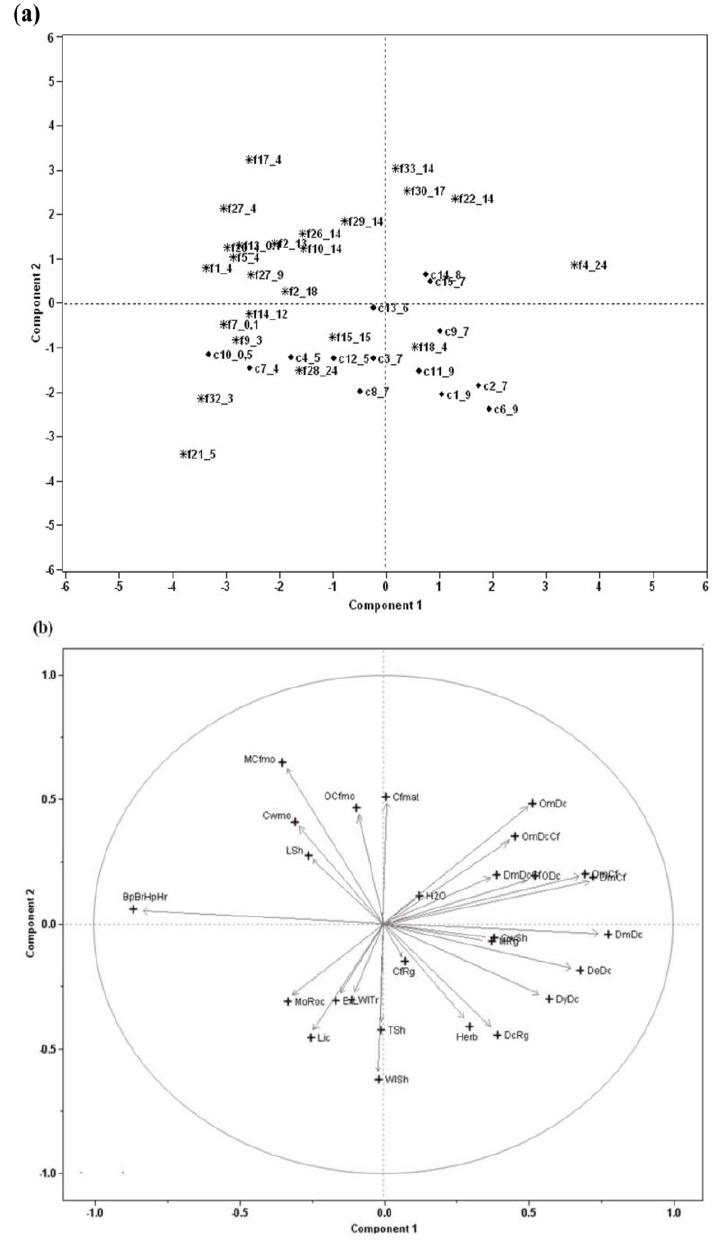
Figure A1. PCA showing the post-disturbance of the land cover types from images of 22 fire events and 14 harvested agglomerations. Each cover type was described using its relative proportion in the disturbed area in the PCA ( a ) Scores: f = fires; c = harvests. First digit = number of disturbances; the second one = time since the last disturbance. ( b ) Loadings (land cover types). MCfmo (medium coniferous cover with moss), DCfmat